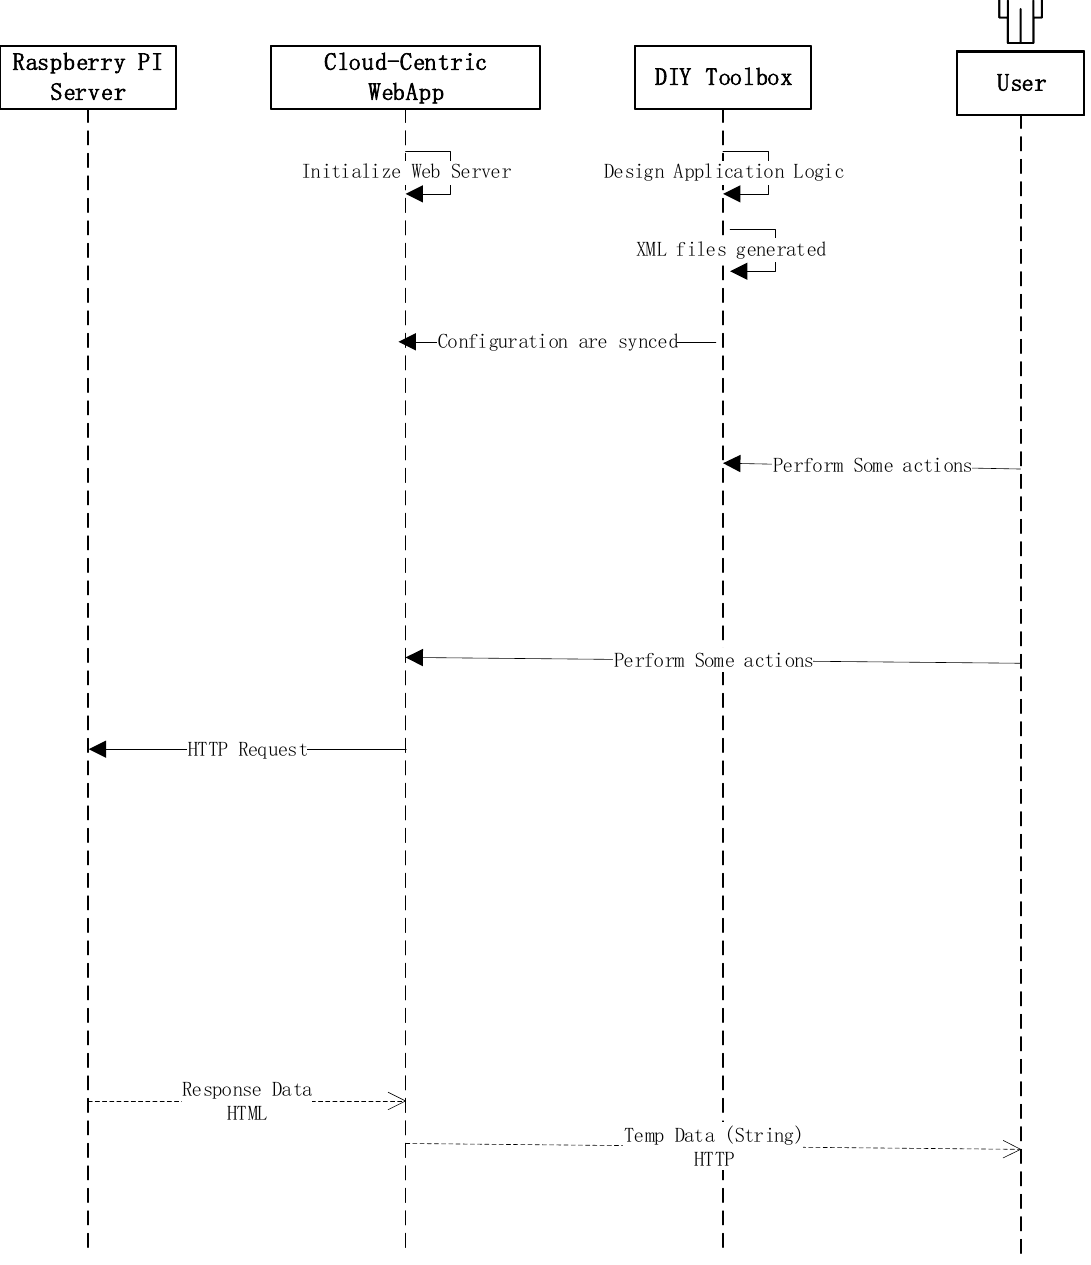
Figure 6. Execution